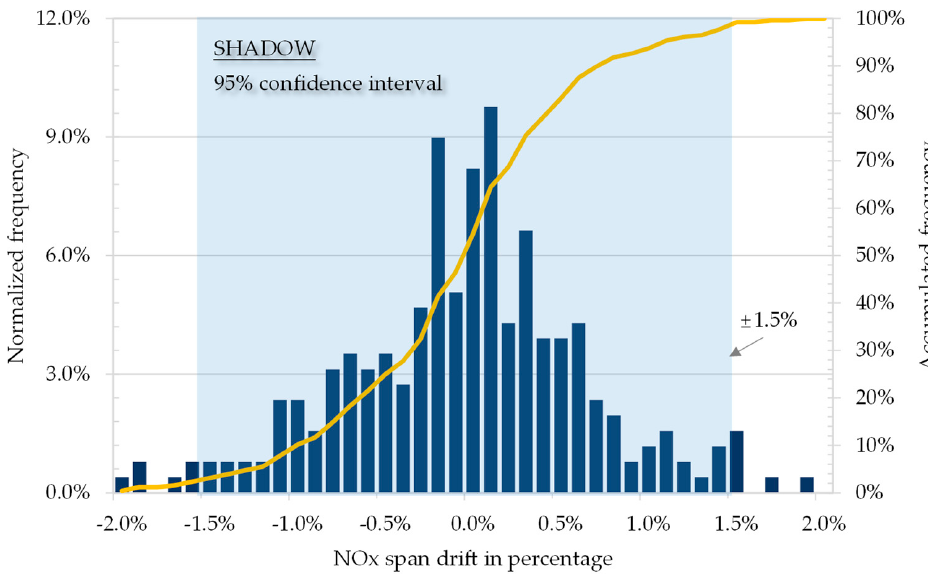
Figure 6. Statistical distribution of span drift events up to a certain concentration level.